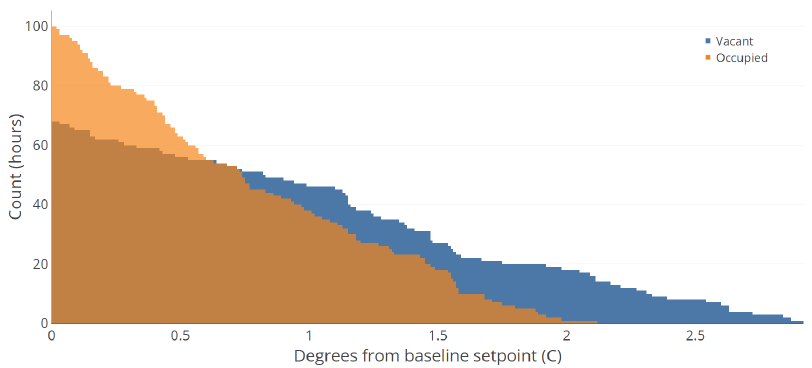
Figure 14. Case 2A duration curve of deviation from 24.5 ◦ C operative